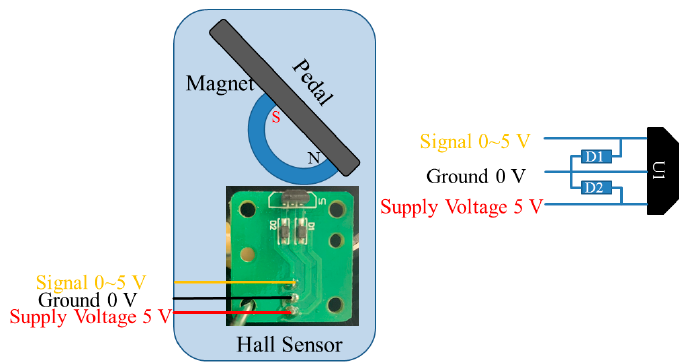
Figure 1. The working principle of the acceleration/brake-by-wire system.